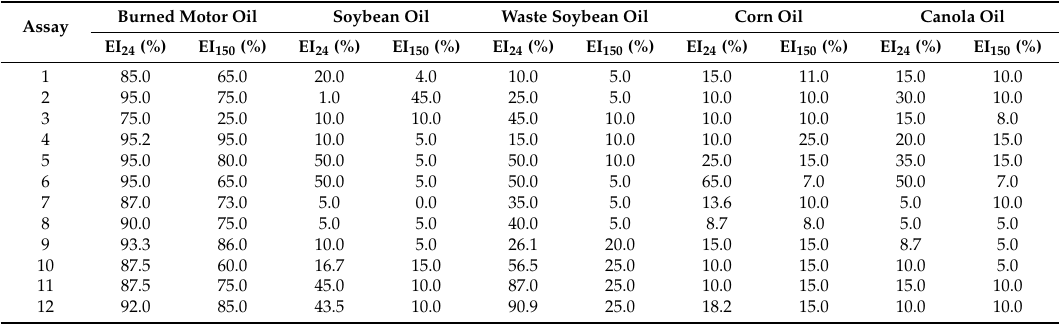
Table 3. The results of a factorial design of 2 3 to evaluate the influence of temperature, agitation, and inoculum volume on the production of a bioemulsifier by Bacillus subtilis UCP 0146, evaluated during 150 days by the emulsification index EI 24 (%) and EI 150 (%). Assay Burned Motor Oil Soybean Oil Waste Soybean Oil Corn Oil Canola